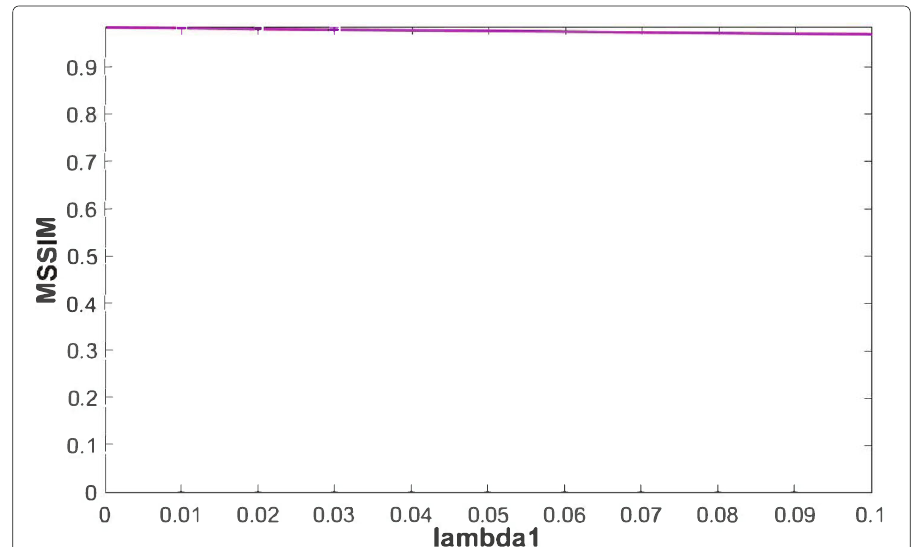
Fig. 7 SSIM of λ 1 in LRTV2++ in parameter optimization